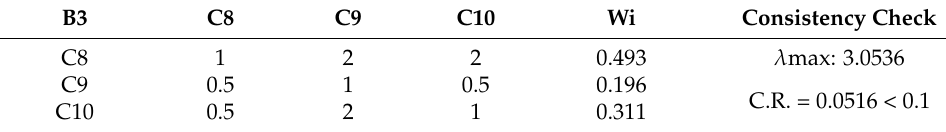
Table 12. B3–C judgment matrix and weight assignment.